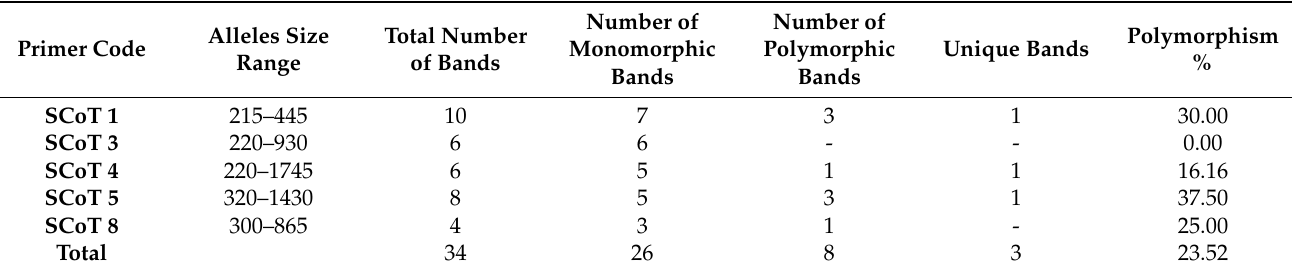
Table 7. Primer code, total number of bands, alleles size range, types of bands (monomorphic, polymorphic, and unique), percent of polymorphism (%), and the polymorphism information content (PIC) for each SCoT primer.